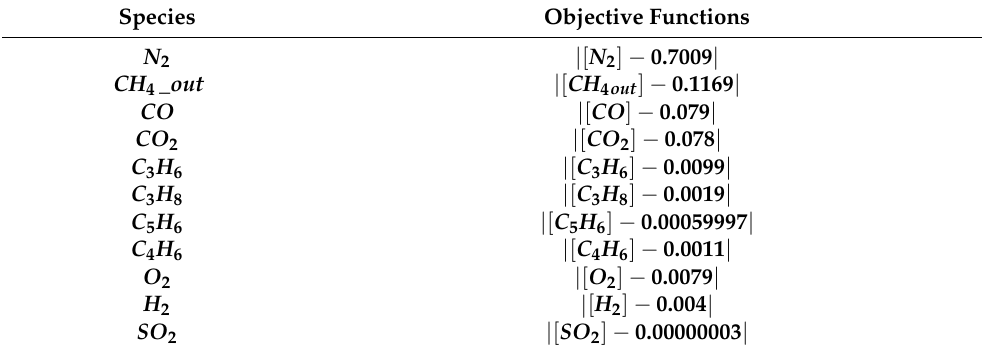
Table 6. Objective functions.